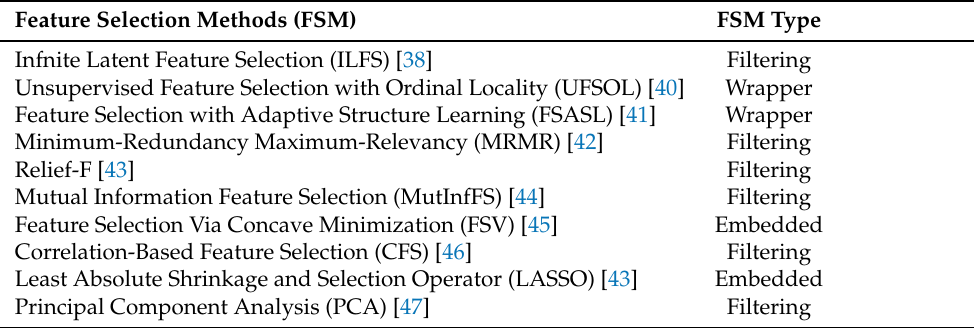
Table 5. Feature Selection Methods Tested for ADL Recognition.